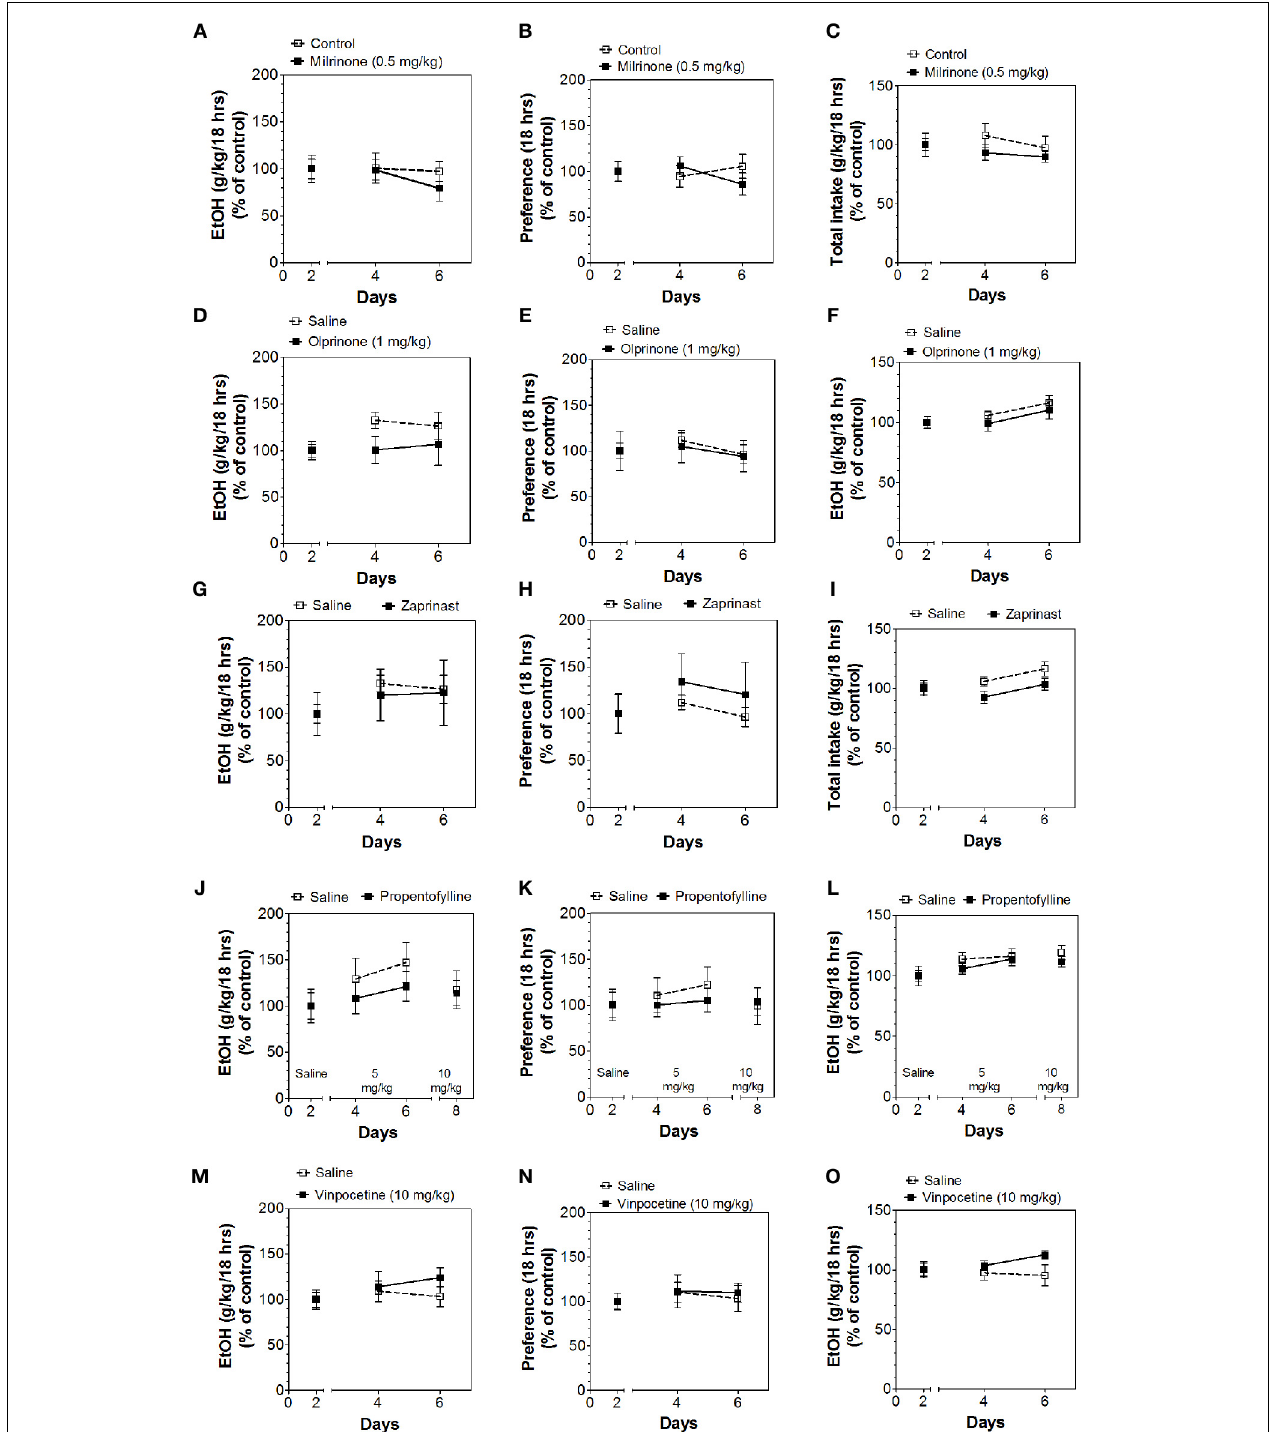
FIGURE 5 | PDE1,3,5 and nonspecific inhibitors do not alter alcohol intake during the last 18h of the 24-h two-bottle choice paradigm. Ethanol consumption is presented as g/kg/18h: (A) Milrinone (D) Olprinone (G) Zaprinast (J) Propentofylline (M) Vinpocetine. Preference for ethanol: (B) Milrinone (E) Olprinone (H)